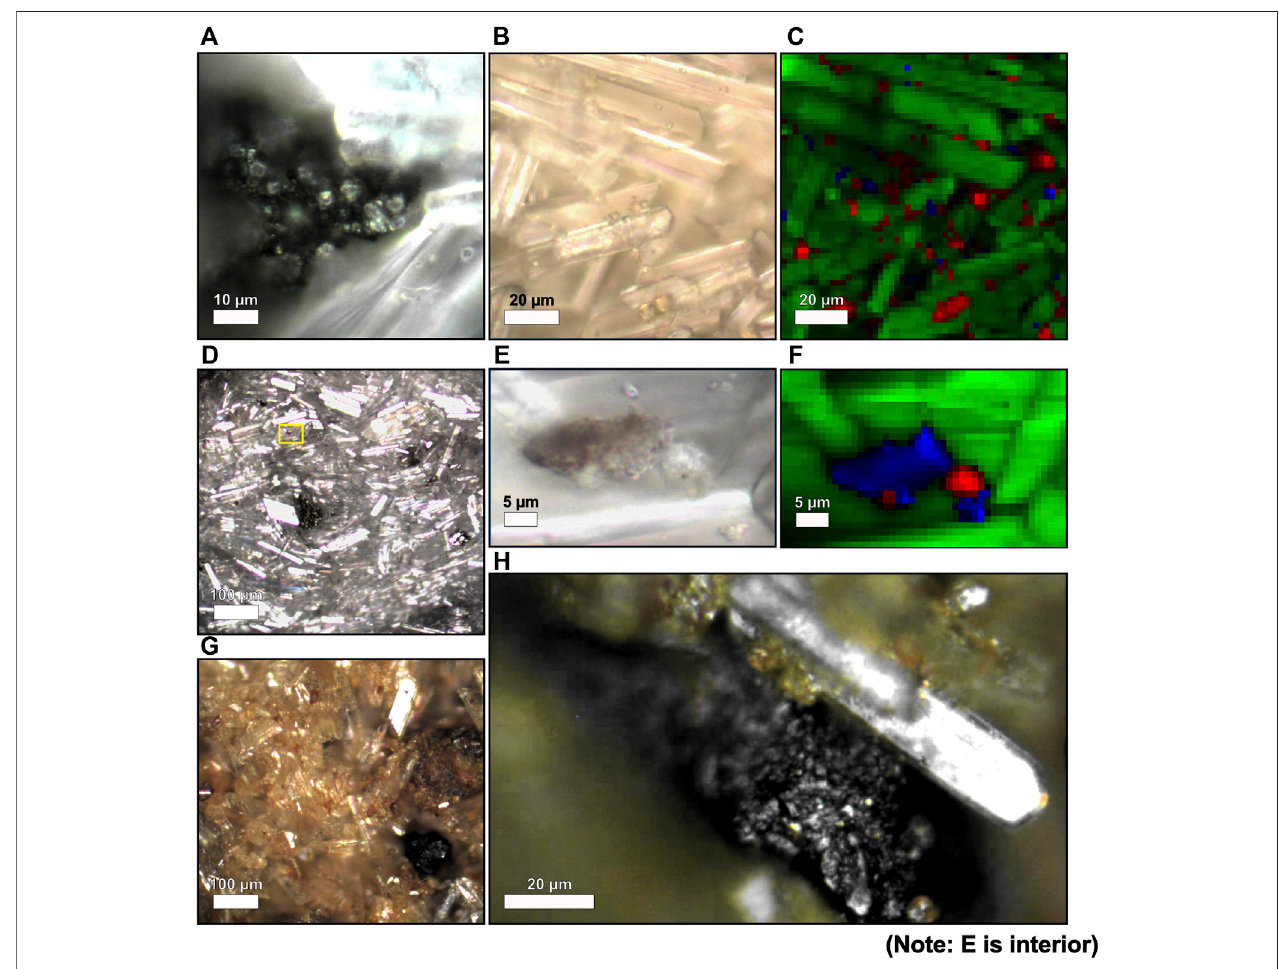
FIGURE 7 | Raman microspectroscopy of North Feature samples. Sample NF1 shows an abundance of gypsum with grains of pyrite, jarosite, and goethite throughout (A – C) . The darkgrain in (A) appears tobe agrain ofpyrite,whichalso revealsdispersed goethite, discretegranules ofjarosite, anatase, and organiccarbon, all set within gypsum. The microscope image in (B) and corresponding Raman spectral map in (C) show tabular grains of gypsum (green in C ; 1,000 – 1,020 cm − 1 ) with smaller grains of jarosite/natrojarosite (red in C ; 425 – 435 cm − 1 ) and various organic carbon-rich spots (blue in C ; 1,500 – 1,650 cm − 1 ). Anatase and goethite were alsodetectedinthismapregion.PyritegrainsareapparentwithinthegypsummatrixofNF2 (D) .Ayellowboxin (D) highlightsaregionwherea “ goop ” oforganicmaterial adhered to a gypsum crystal was detected. This material, shown in (E) and (F) , revealed two globules of elemental sulfur (red in F ; 205 – 225 cm − 1 ) with a large clump of organiccarbon(bluein F ;1,500 – 1,650 cm − 1 ).Thegreenin F signi fi esgypsum( fi ttingintensitiesfrom1,000to1,020 cm − 1 ).SampleNF3showedagreaterabundanceof red/orange staining from goethite (G) . A low-resolution spectral map of the region in (G) revealed the presence of anatase, quartz, goethite, and gypsum in this region. One region showed a grain of gypsum along with abundant goethite and jarosite as well as organic carbon and anatase in sample NF3 (H) .